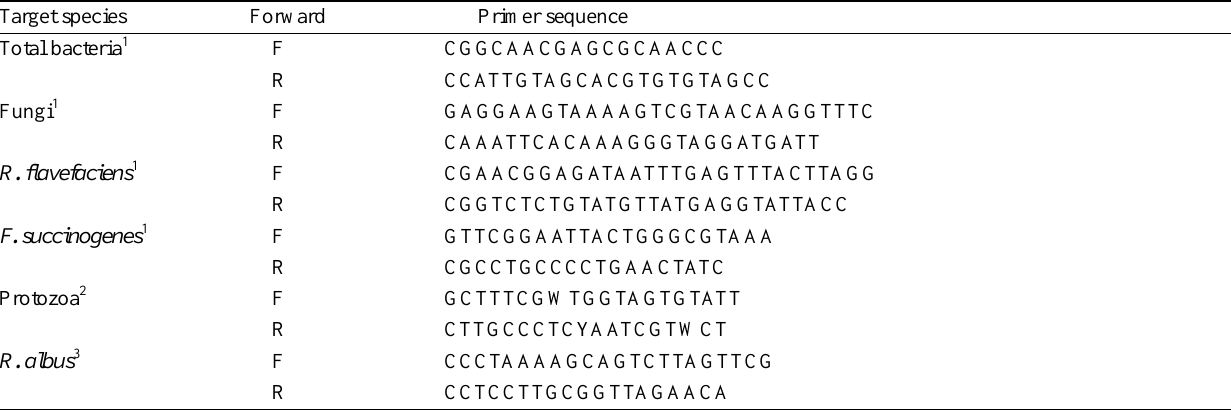
Table 3. PCR primers for real-time PCR assay Target